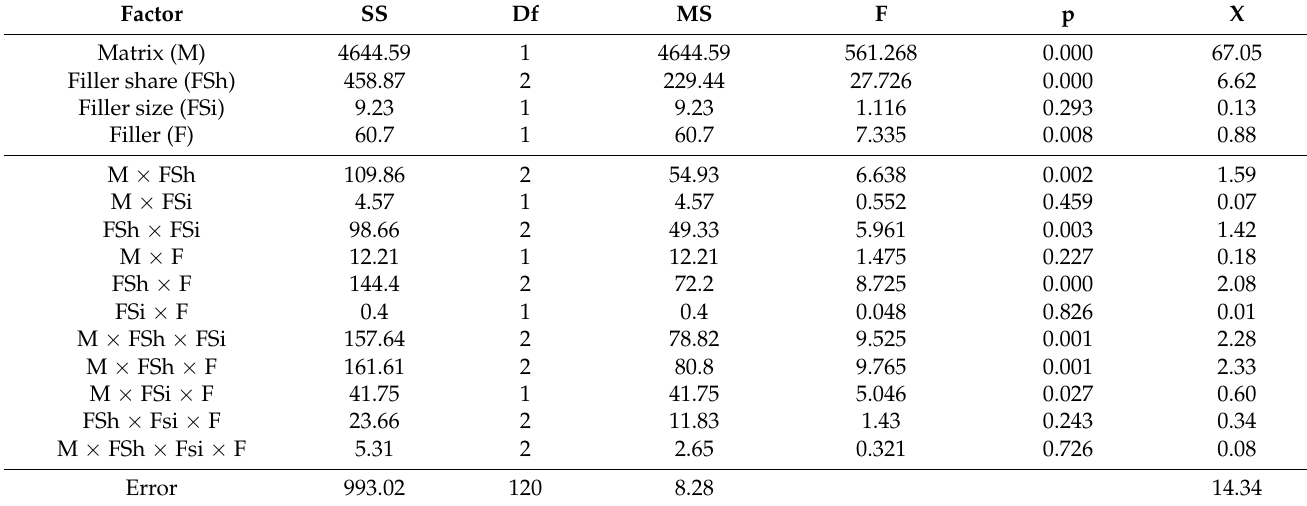
Table 5. Analysis of variance for selected factors and interactions between the factors influencing the axial force during